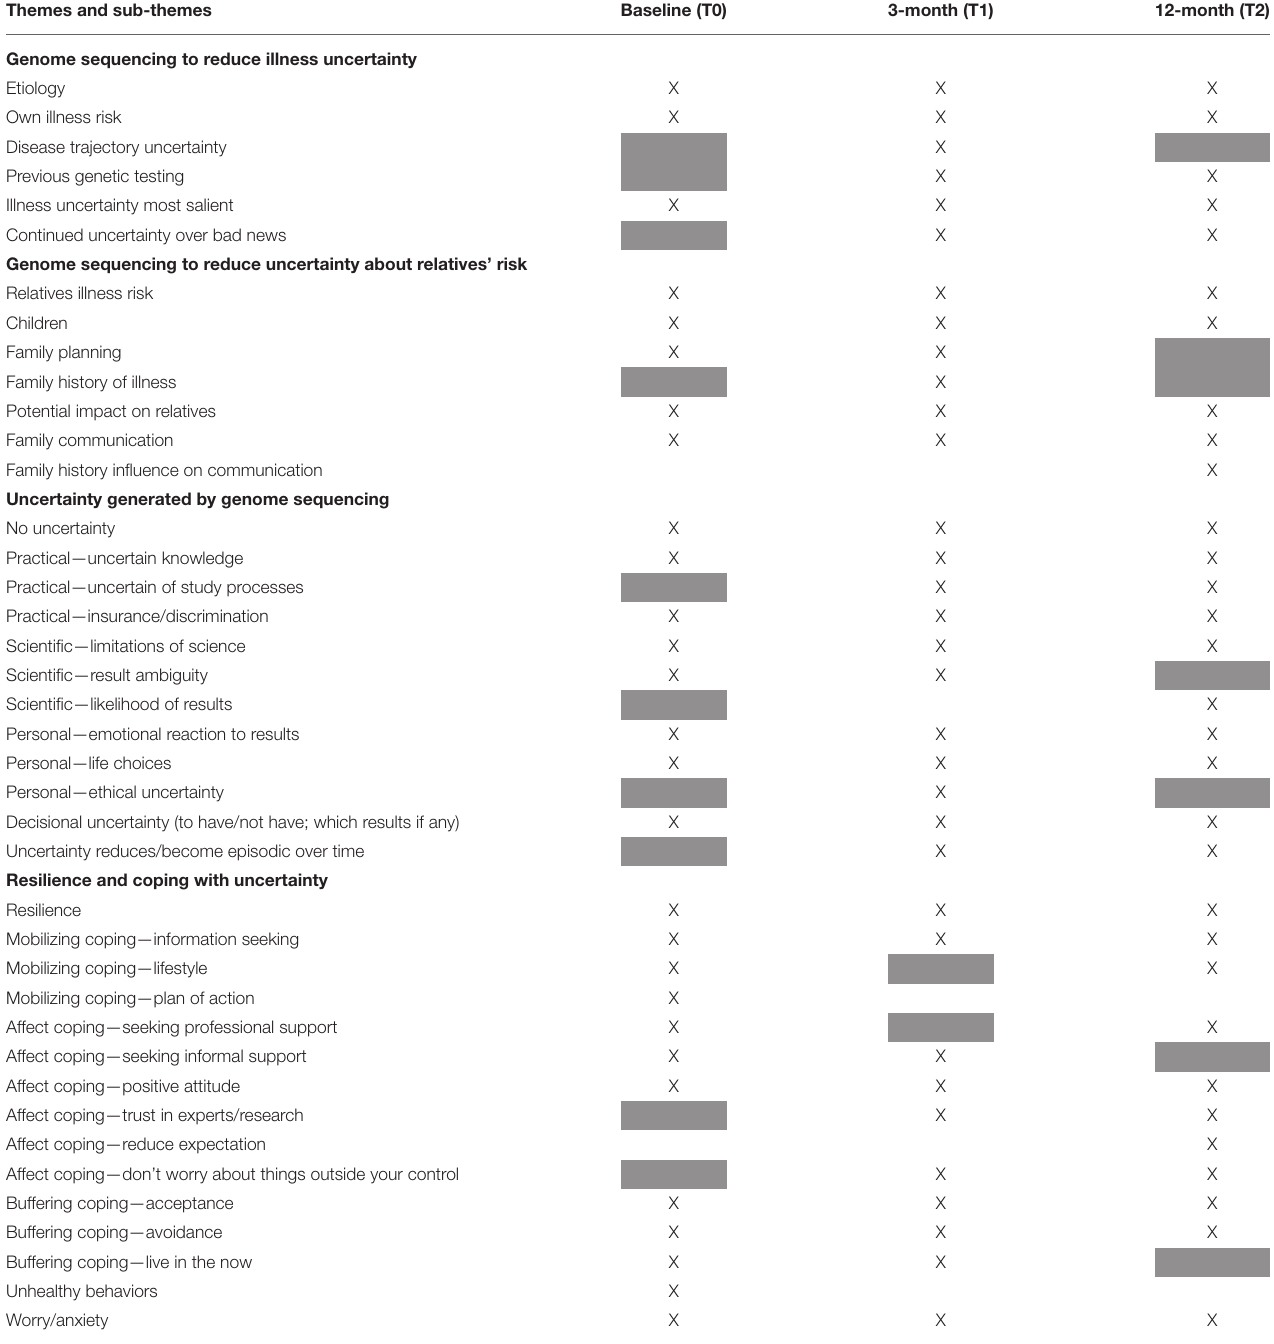
TABLE 4 | Uncertainty themes and sub-themes discussed by PiGeOn interviewees over 12 months. Themes and